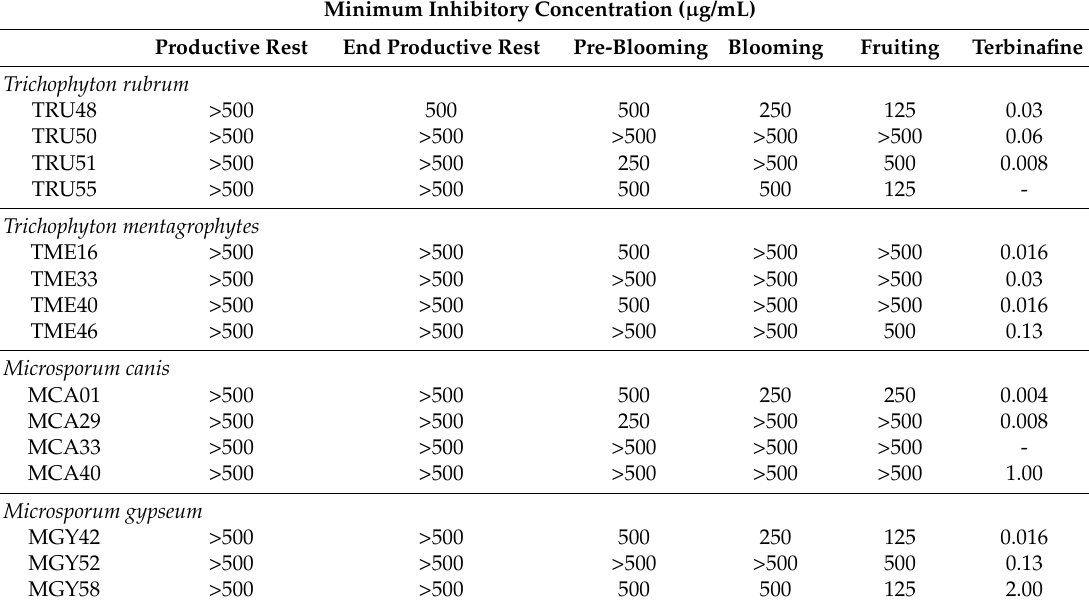
Table 3. Minimum inhibitory concentration (MIC) of essential oils from the leaves of Nectandra megapotamica collected during different developmental phases of the plant against